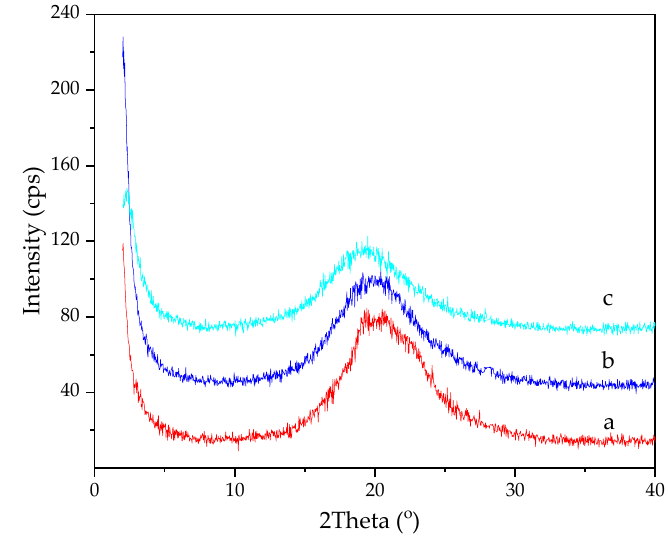
Figure 3. WAXD of CP40 at: 293 K ( a ), 323 K ( b ) and 393 K ( c ). This diffraction angle region also coincides with the WAXD pattern of crystalline poly (ethylene oxide) [35]. Therefore, it can be reasonably concluded that the melting observed in CP20 and CP40 cameomes from a main chain partial crystallization of the polyether chain.